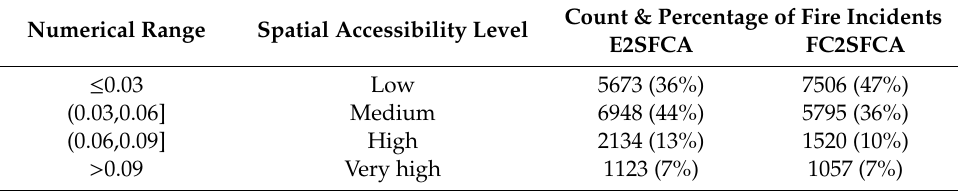
Table 2. The levels of spatial accessibility for E2SFCA and